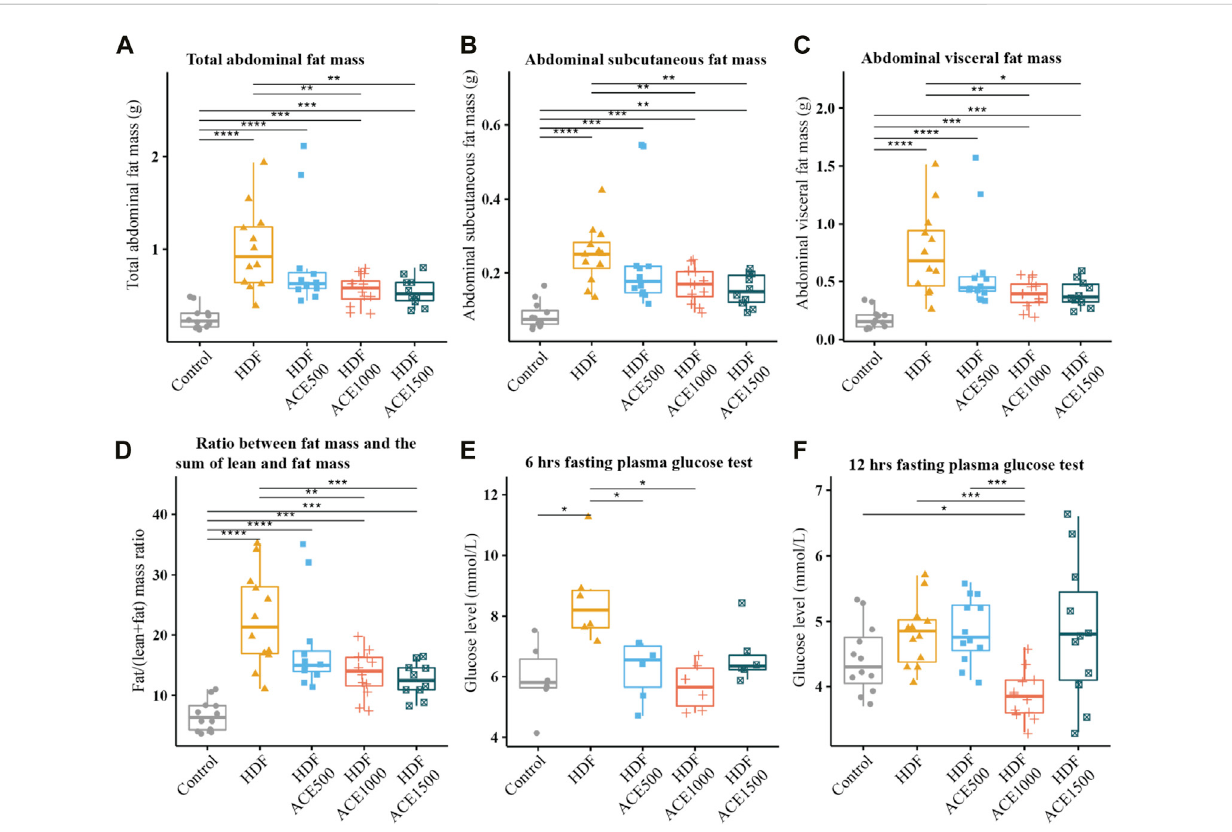
FIGURE 2 Invivo studywithacetylglycine.Panels (A – D) showthepairwisecomparisonsfortheµ-CTmeasuresamongdifferentgroups.Theabdominalregion was de fi ned as between L1 – L5lumbar vertebrae. Panels( E, F) are the pairwise comparisons for the fasting plasma glucosetest. FDR: false discovery rate; *: FDR q -value < 0.05; **: FDR q -value < 0.01; ***: FDR q -value < 0.001; ****: FDR q -value <